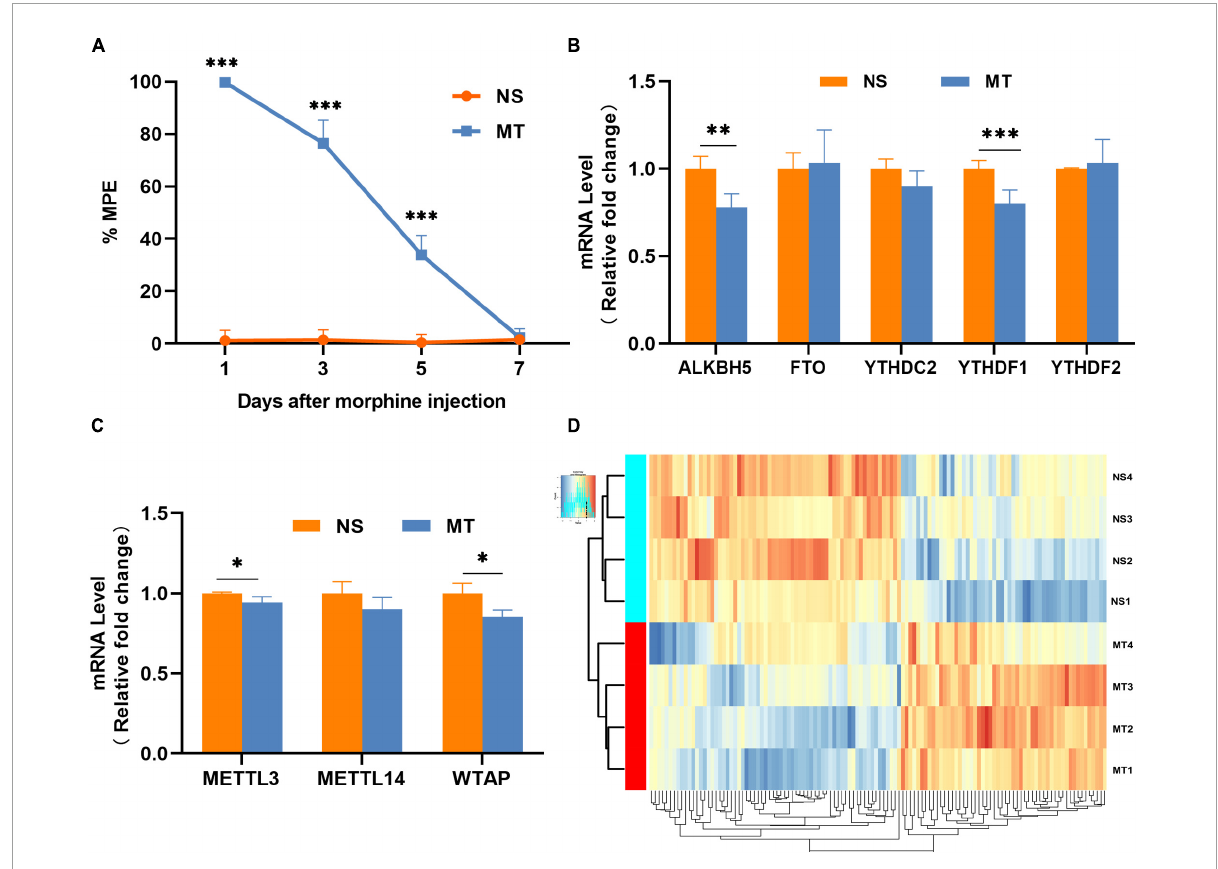
FIGURE1 The animal model and the overall features of m 6 A-circRNA in morphine-tolerant rats. (A) Morphine-induced antinociception was assessed through the tail-flick test, and tail-flick latency was converted to %MPE ( n = 4), ∗∗∗ P < 0.001 compared with the NS group using Two-way repeated measures of ANOVA followed by Bonferroni’s post-hoc test. (B) Expression of RNA demethylase and methyltransferase determined by qRT-PCR. ( n = 4) ∗∗ P < 0.01, ∗∗∗ P < 0.001 compared with the NS group using a two-tailed unpaired Student’s t -test. (C) Expression of RNA methylase determined by qRT-PCR ( n = 4). ∗ P < 0.05 compared with the NS group using a two-tailed unpaired Student’s t -test. (D) Hierarchical clustering shows global m 6 A-methylated circRNAs between the MT group and NS group ( n =